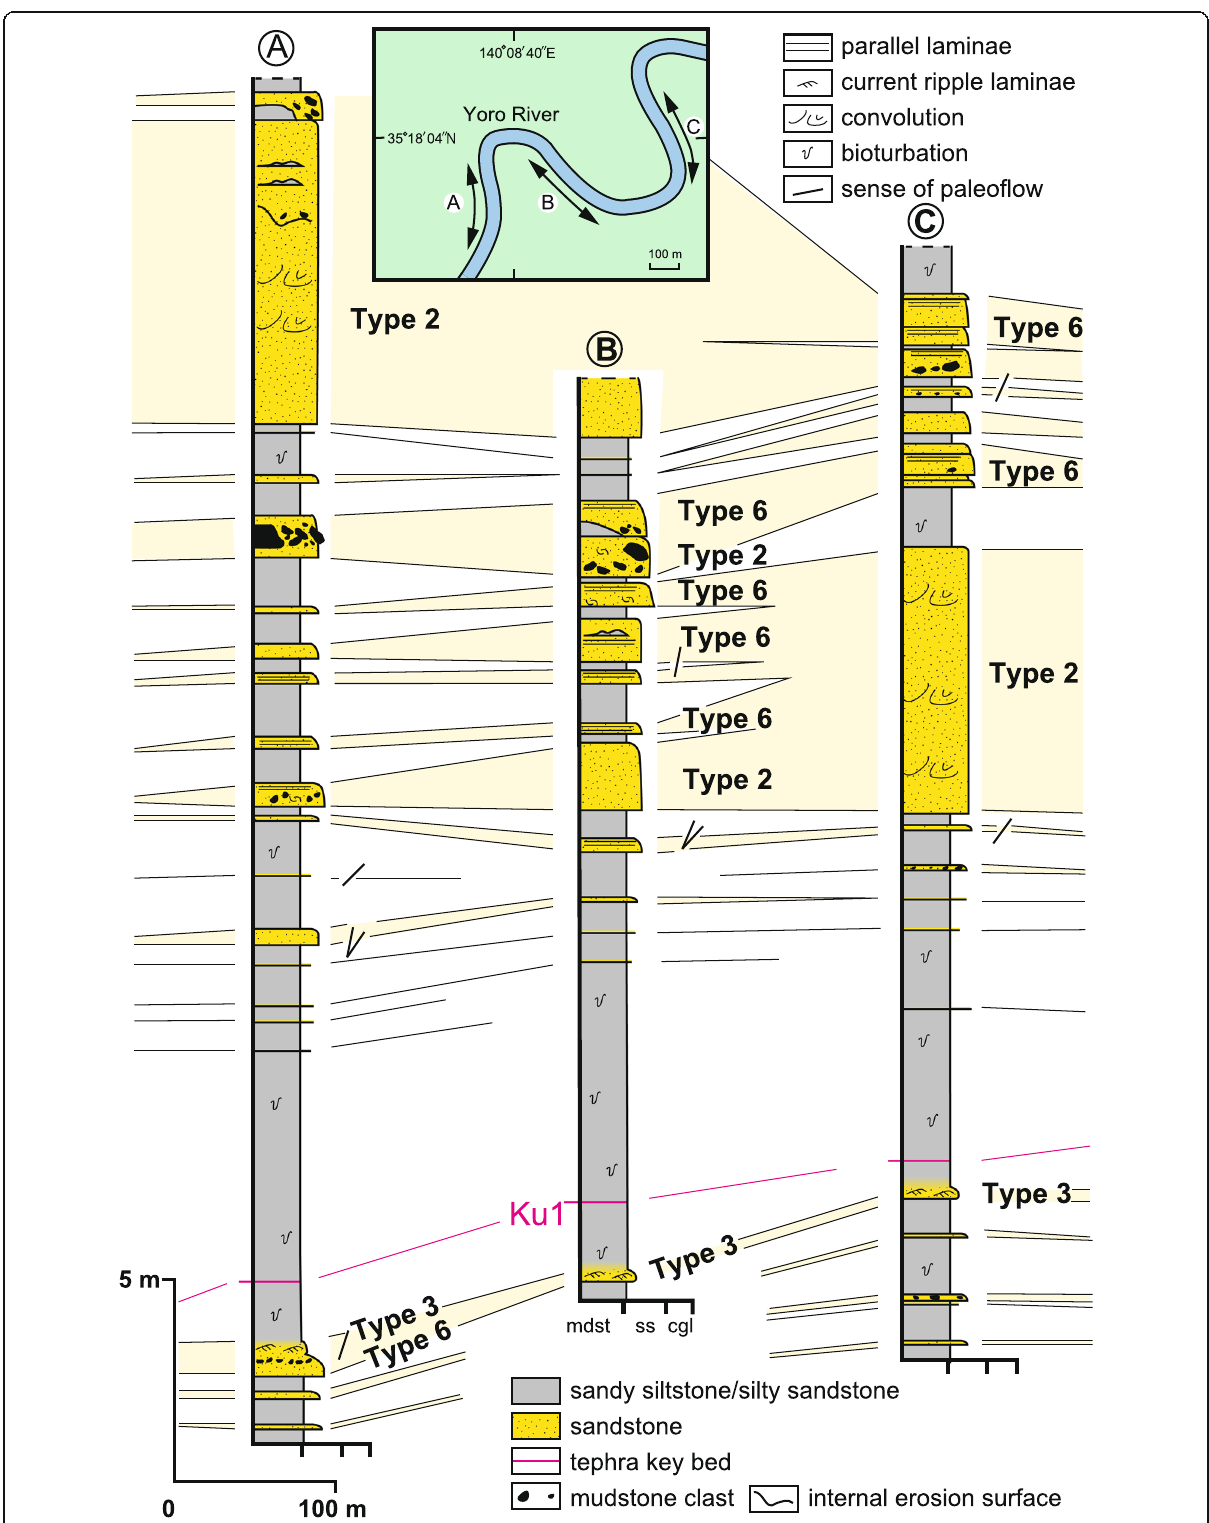
Fig. 9 Downflow changes in lithofacies types of sandstone beds above the Ku1 tephra key bed in PK2 of the Kokumoto Formation along the Yoro River (Location 4 in Fig. 4). The inset map shows the locations of the measured sections. See Table 1 for descriptions and interpretations of lithofacies